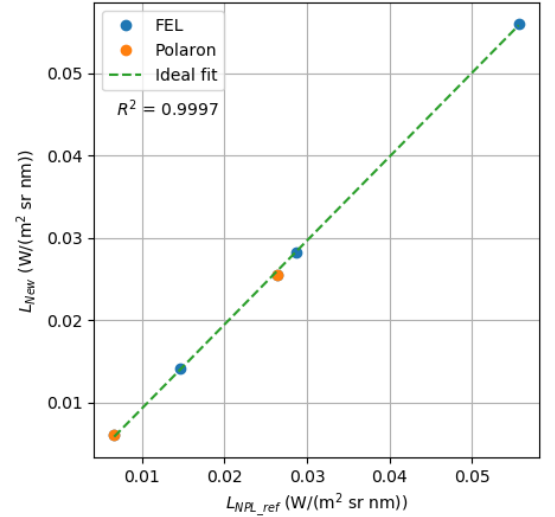
Figure 5. Linearity plot for band 27 (centre wavelength = 748.81 nm).